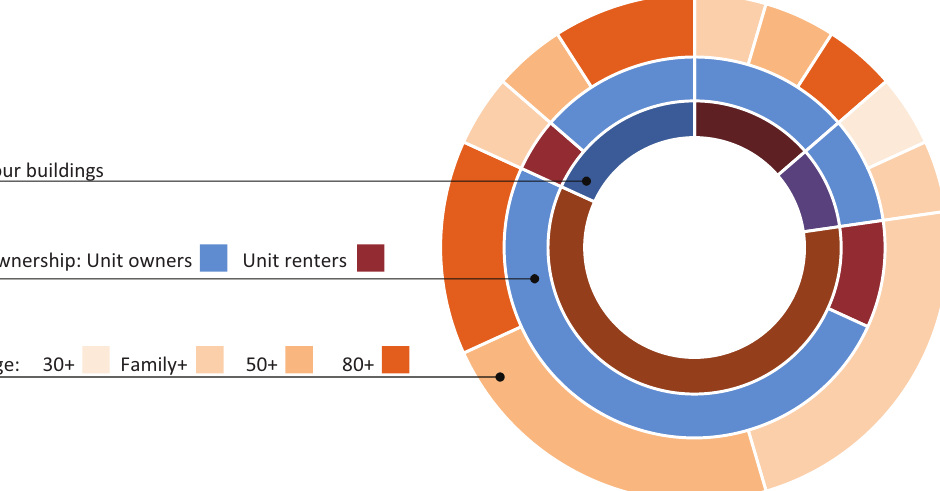
Figure 10. Diagram of the interviews conducted by this study. Interviewees are segmented per residence in each of the estate’s buildings, owners vs. renters, and age group.